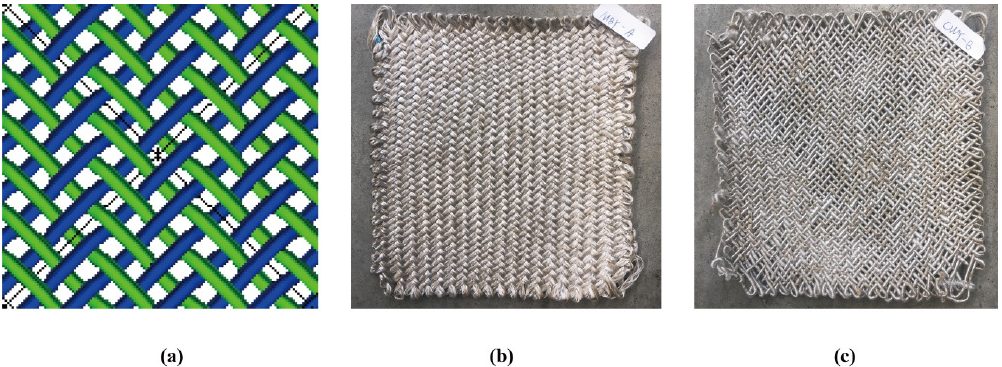
Figure 3. The 2D braiding: ( a ) illustration of braiding pattern (regular braid 2:2-1 overlap); ( b ) micro-braided yarn with 20° braiding angle (MBY-A) braids; ( c ) co-wrapped yarn with 1000 tpm (CWY-B) braids.